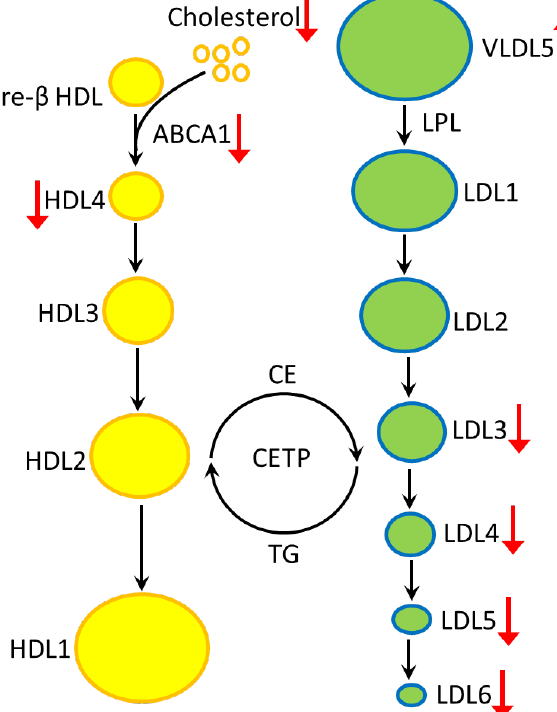
Figure 4. The altered profiles of lipoproteins in plasma of HD are summarized. HDL4, LDL3, LDL4 and LDL5 are reduced, while VLDL5 is increased in the plasma of HD patients. The reduced HDL4 may be generated by reduced ABCA1-mediated cholesterol efflux or decreased cholesterol generation. The mechanism of how ABCA1 deficiency affects VLDL and LDL subfractions remains uncer-